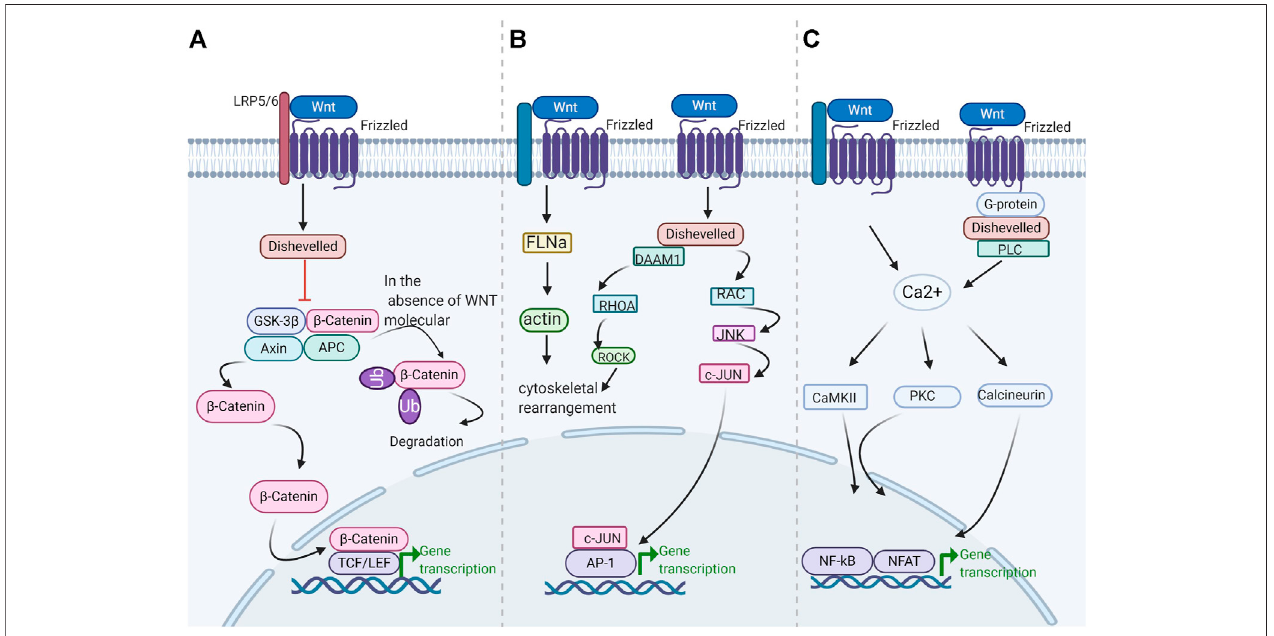
FIGURE1| SchematicdiagramoftheWnt/ β -cateninpathway.Wntsignalingistransmittedthroughatleastthreedifferentintracellularpathways (A) canonicalWnt/ β -catenin signaling pathway (B) Wnt/Ca 2+ pathway (C) Wnt/PCP